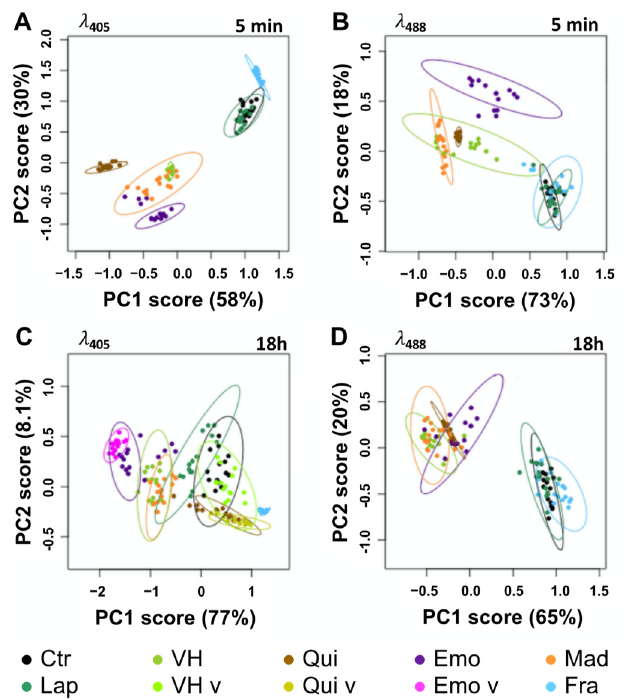
Figure 5. PCA of normalized average spectra obtained by SImaging analysis of BY-2 cells treated or not (Ctr) with 25 µ M of phenolic compounds. ( A , B ) Differences observed after 5 min treatments and ( C , D ) 18 h with vismione H VH, madagascine Mad, emodin Emo, quinizarin Qui, fraxetin Fra, and lapachol Lap. Spectra observed at λ 405 ( A , C ) and λ 488 ( B , D ) in control and treated cells. Spectra found in the primary vacuole at λ 405 after 18 h are specified with a “v” after the labels if another fluorescence was observed in the cytoplasm. Ellipses are representative of qualitative differences with a p ≤ 0.05 for the PCA analysis of normalized average A B